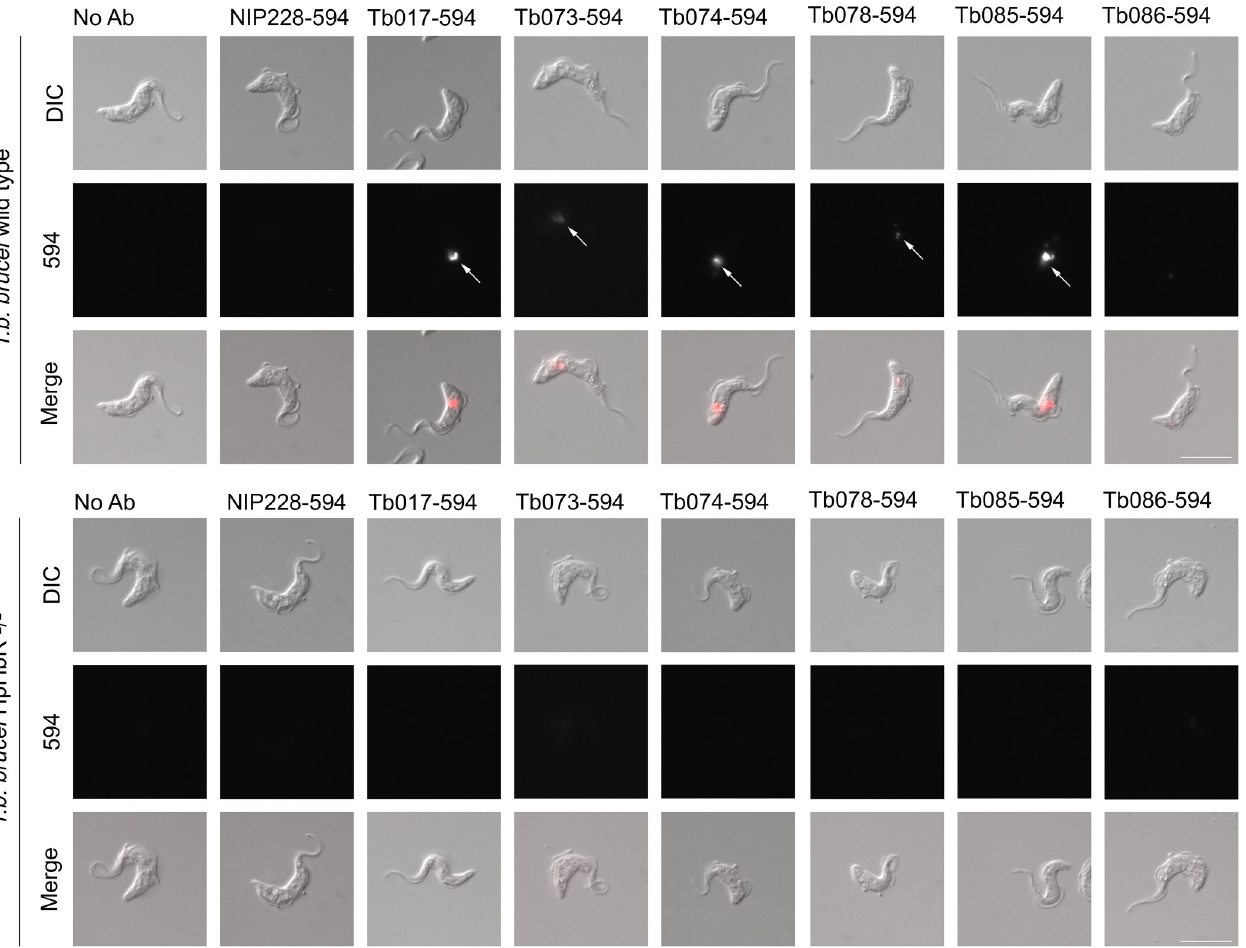
Fig 2. Receptor mediated endocytosis of humanised anti-HpHbR IgG1s. Uptake of Alexa594-labelled antibodies into T . b . brucei Lister 427 HpHbR wild type and -/- cells was monitored by microscopy. Uptake of five of the seven selected antibodies was detected at 10 nM in wild-type (indicated by arrows in upper panel) but not in HpHbR -/- cells (lower panel). No specific uptake of the remaining antibody (Tb086) or a control antibody (NIP228) was detected. Scale bar represents 10 μ m.